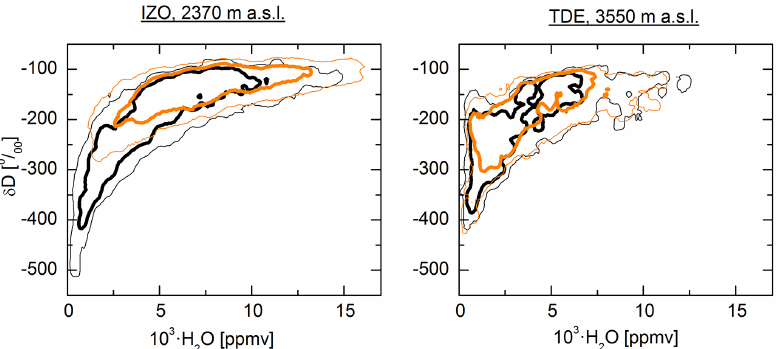
Figure B1. H 2 O- δ D distributions as obtained for the “night-time observation” (10min averages made between midnight and 1h after sunrise, black contour lines) and the “daytime observations” (10min averages made between 3 and 10h after sunrise, orange contour lines). The thin and thick lines mark areas that include 95 and 66% of all the data. The plot shows the density distributions of the data points from Fig.